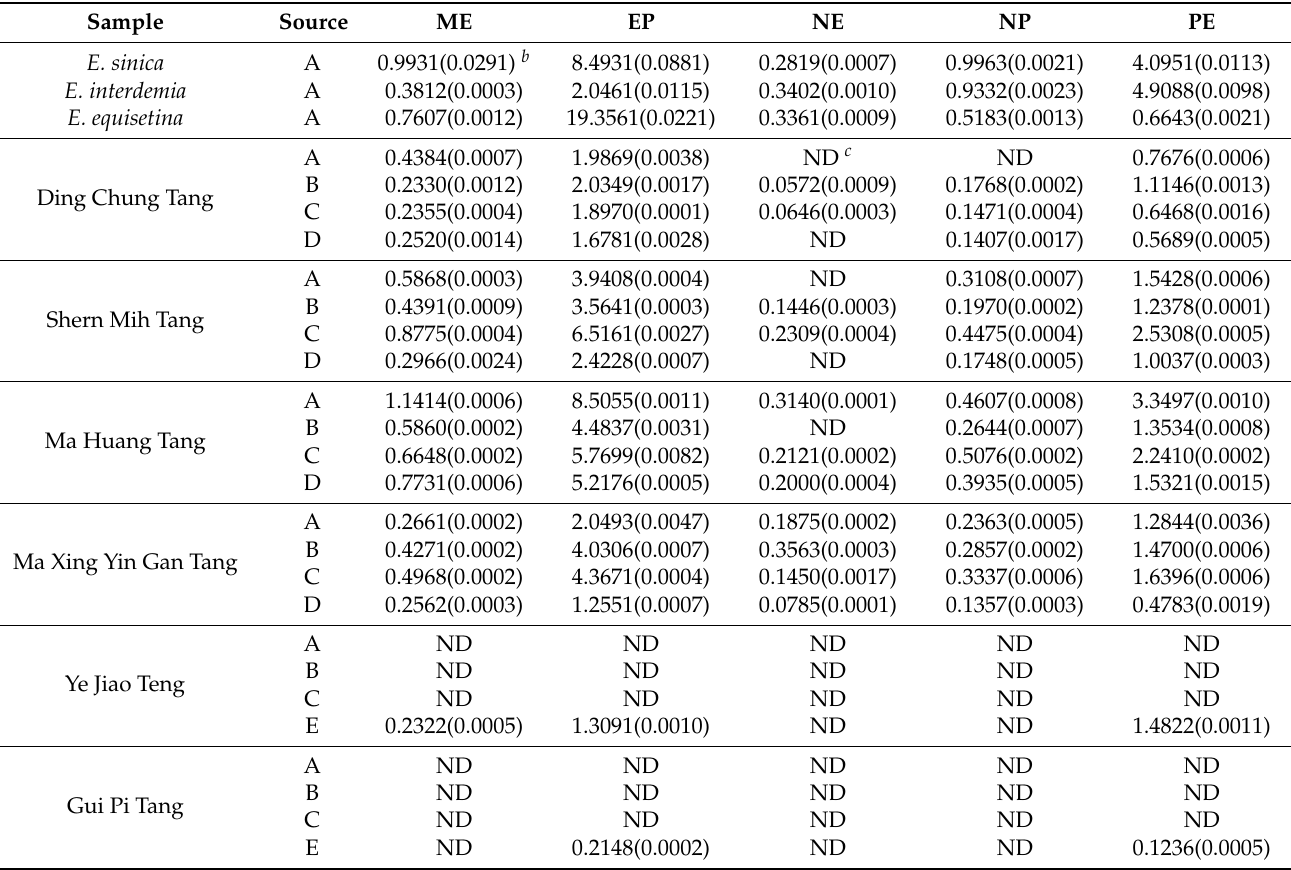
Table 2. The concentrations (mg/g) of ephedrine alkaloid derivatives, including methylephedrine (ME), ephedrine (EP), norephedrine (NE), norpseudoephedrine (NP), pseudoephedrine (PE), and methylpseudoephedrine (MP), in E. sinica , E. intermedia , and E. equisetina extracts and several Ephedra -related commercial prescriptions (companies A~E) a .